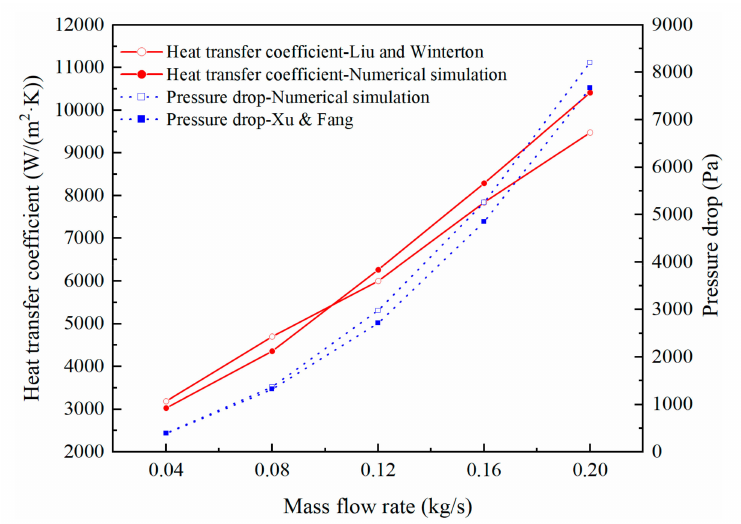
Figure 4. Validation of numerical simulation results with empirical